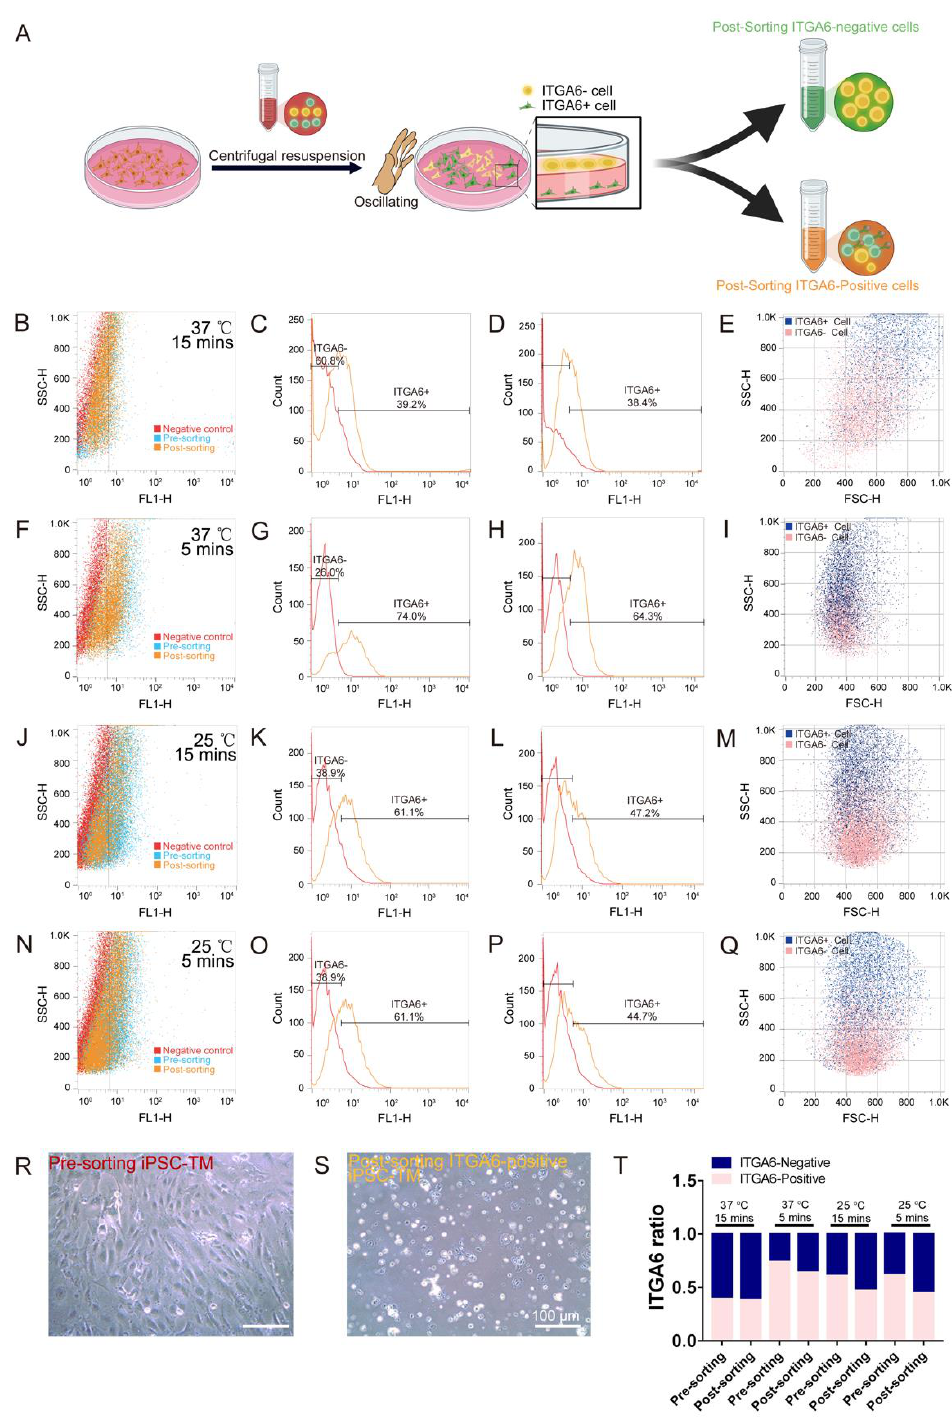
Figure 4. The IP-based purification of ITGA6-positive iPSC-TM. ( A ) Schematic illustration of the ITGA6-positive purification process by IP. iPSC-TM was seeded on a dish pre-coated with the ITGA6 antibody. After oscillation, ITGA6-positive iPSC-TM cells (green) adhered to the dish, while the ITGA6-negative iPSC-TM (yellow) cells floated in the medium. ( B – Q ) The ratio of ITGA6-positive cells after IP-based sorting by oscillation at different conditions: ( B – E ) 37 °C every 15 min; ( F – I ) 37 °C every 5 min; ( N – Q ) 25 °C every 15 min; or ( J – M ) 25 °C every 5 min. ( R , S ) Representative images of the cell morphology of pre-sorted iPSC-TM and ITGA6-positive iPSC-TM after IP. Scale bars, 100 µm. ( T ). Quantification analysis of the ratios of the ITGA6-positive cells (pink) and ITGA6-negative cells (blue).